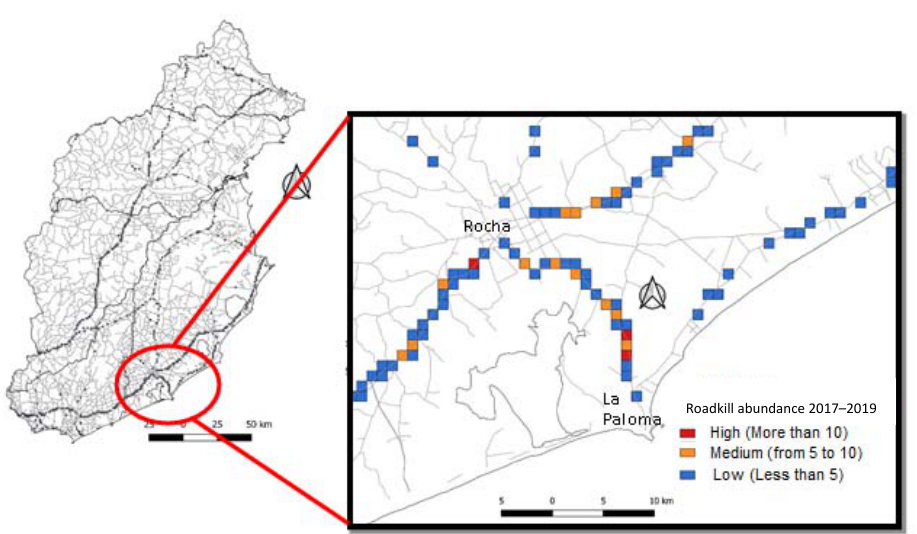
Figure 6. Map of roadkill abundances in the period 2017–2019 showing the section of Route 15 that connects the city of Rocha with La Paloma with the sites with the highest mortality.